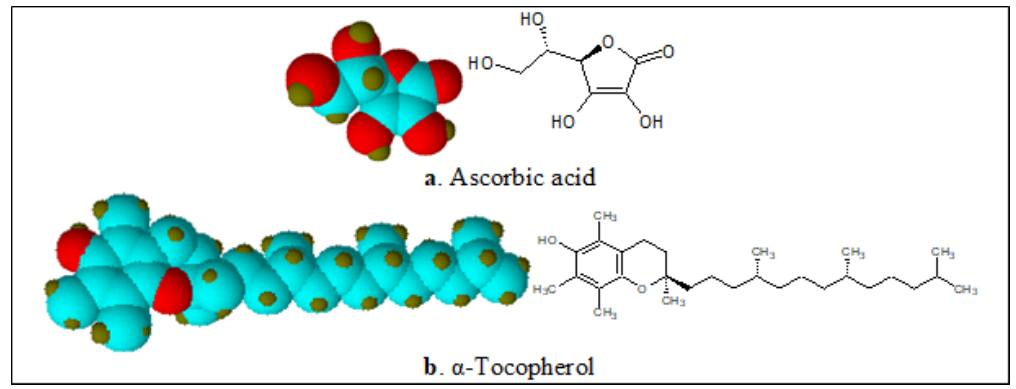
Figure 13. Structures and 3D models of ascorbic acid (AA) and E307 ( α -tocopherol) molecules.